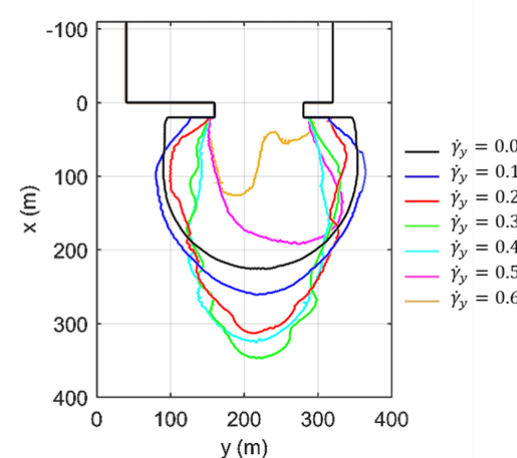
Figure 15. The stoppage boundary profiles of FGT66 predicted by the modified bi-viscosity model (MBM) for sensitivity analysis of yield strain rate 𝛾̇ y (unit: s −1 ). (MBM) for sensitivity analysis of yield strain rate